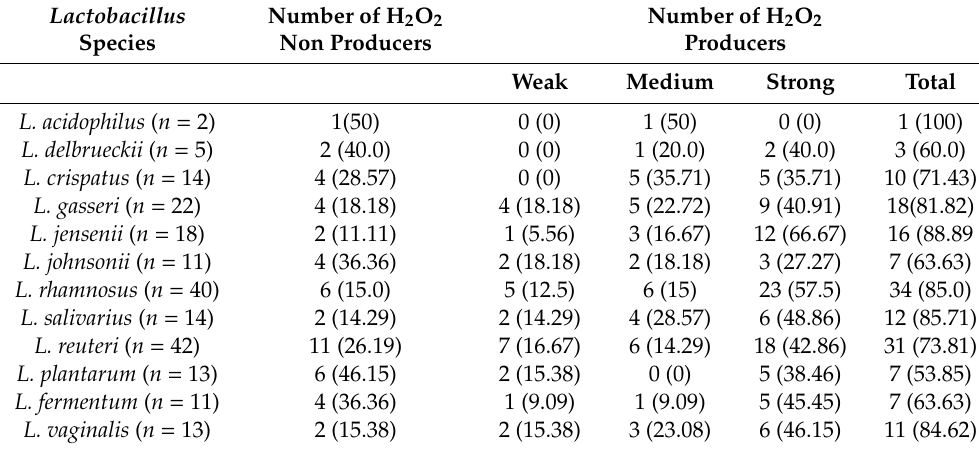
Semi-quantitative distribution of H 2 O 2 production by di ff erent Lactobacillus species. The number in the parenthesis denotes the